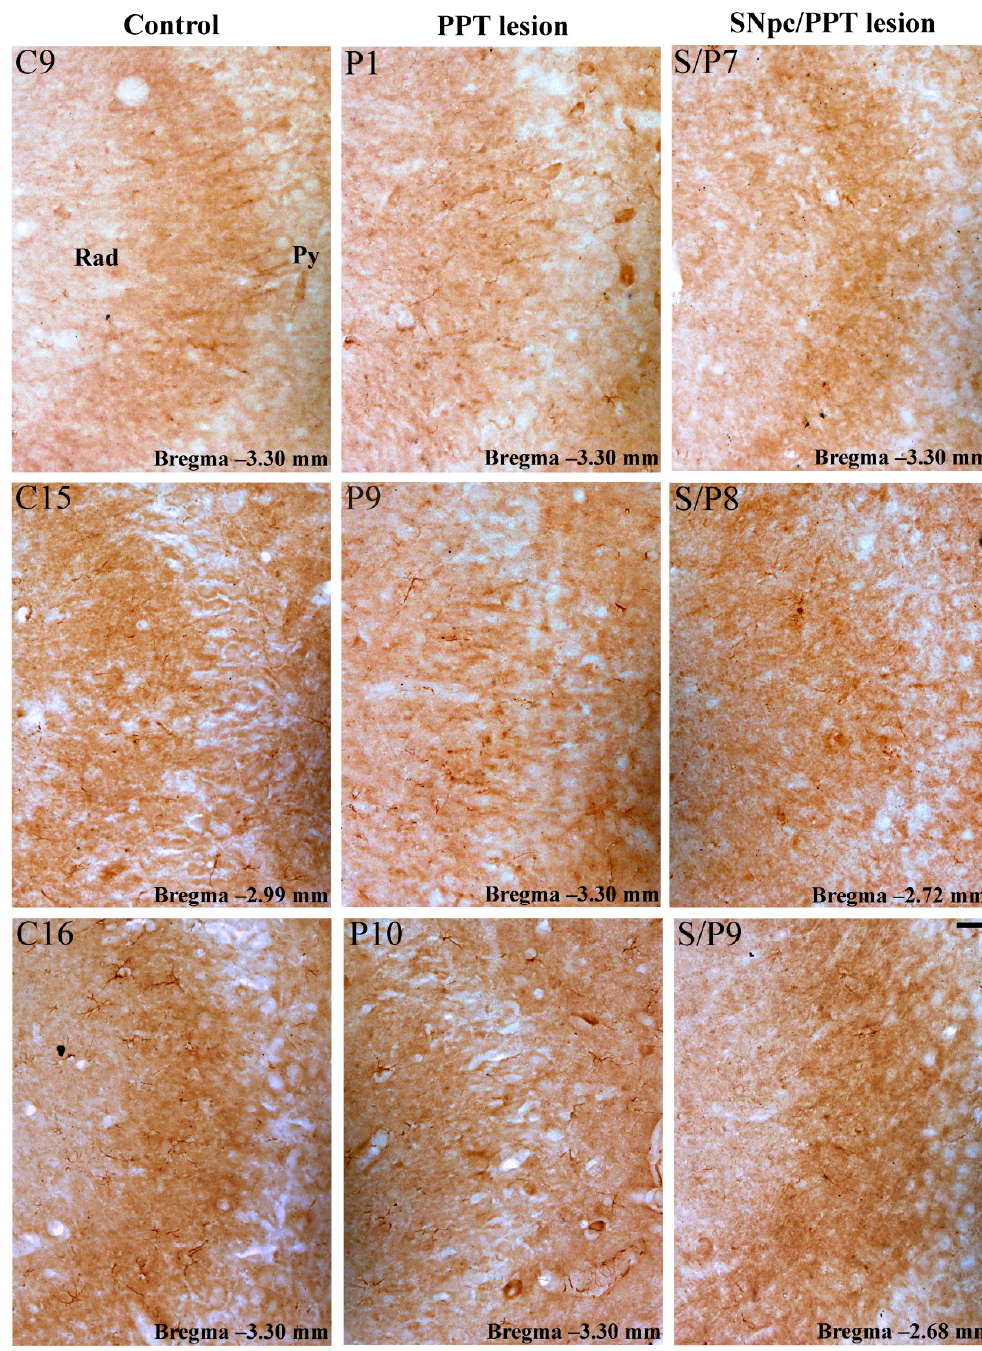
Figure 10. Alteration of PSD-95 immunostaining within the hippocampal CA3 in the distinct rat models of PD neuropathology. PSD-95 immunoreactivity within CA3 of the control rats (Control, C9, C15, C16), the rats with PD cholinopathy (PPT lesion, P1, P9, P10) and the hemiparkinsonian rats with PD cholinopathy (SNpc/PPT lesion, S/P7, S/P8, S/P9). Py—pyramidal cell layer of the hippocampus; Rad—radiatum layer of the hippocampus. Scale bar is 25 μ m. PSD-95 immunoreactivity was suppressed in the rats with PD cholinopathy within the pyramidal cell layer and stratum radiatum of the hippocampal CA3 region vs. the control rats and the hemiparkinsonian rats with PD cholinopathy.